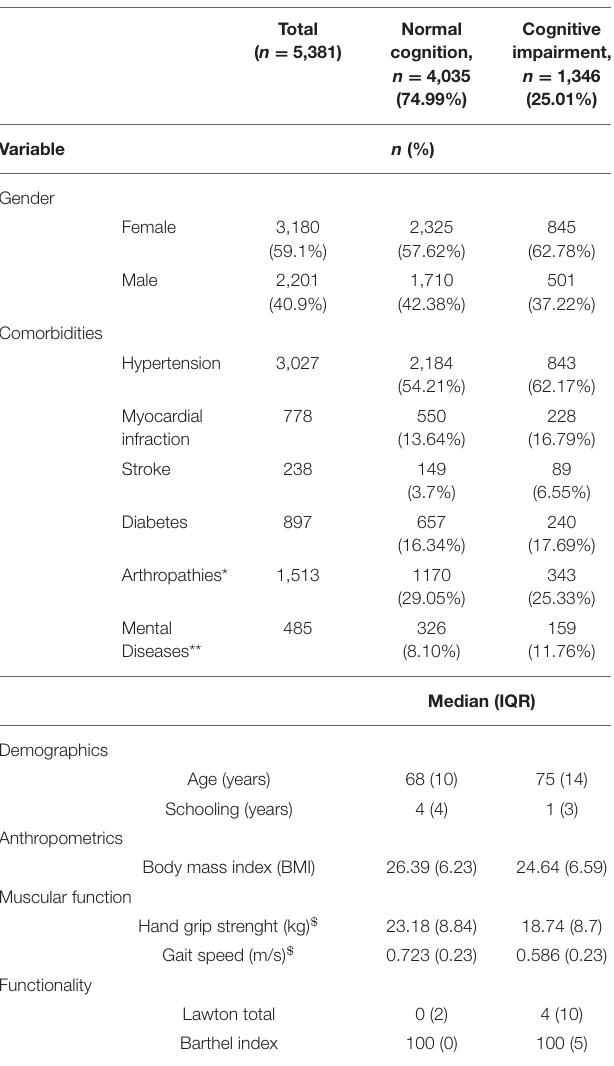
TABLE 1 | Descriptive analysis by cognitive